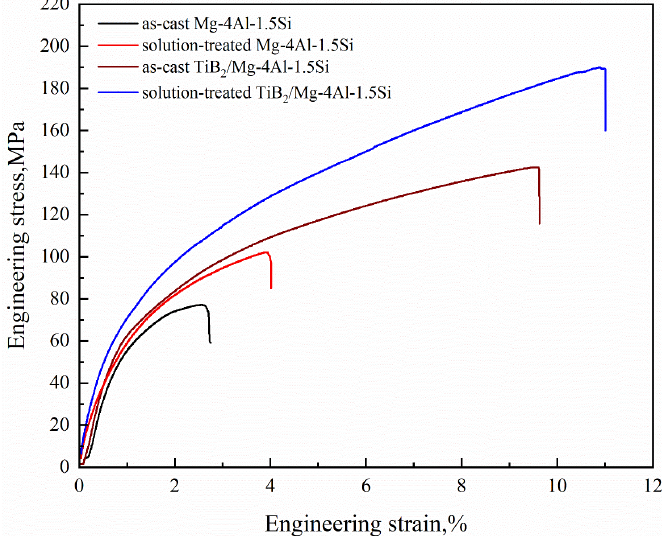
Figure 8. Typical tensile stress-strain curves of the alloys and the composites in as-cast state and after solution treatment.